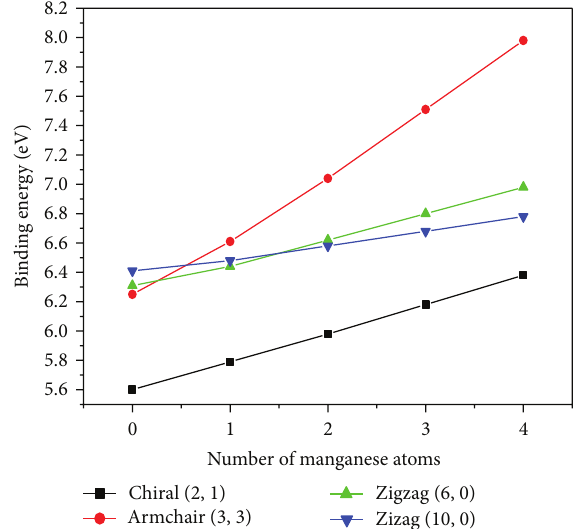
Figure 2: Binding energy as a function of Mn atoms, where black square,redcircle,greenuppertriangle,andbluebelowfacedtriangle correspond to chiral (2, 1), armchair (3, 3), (6, 0), and (10, 0), and zigzag GaN nanotubes,